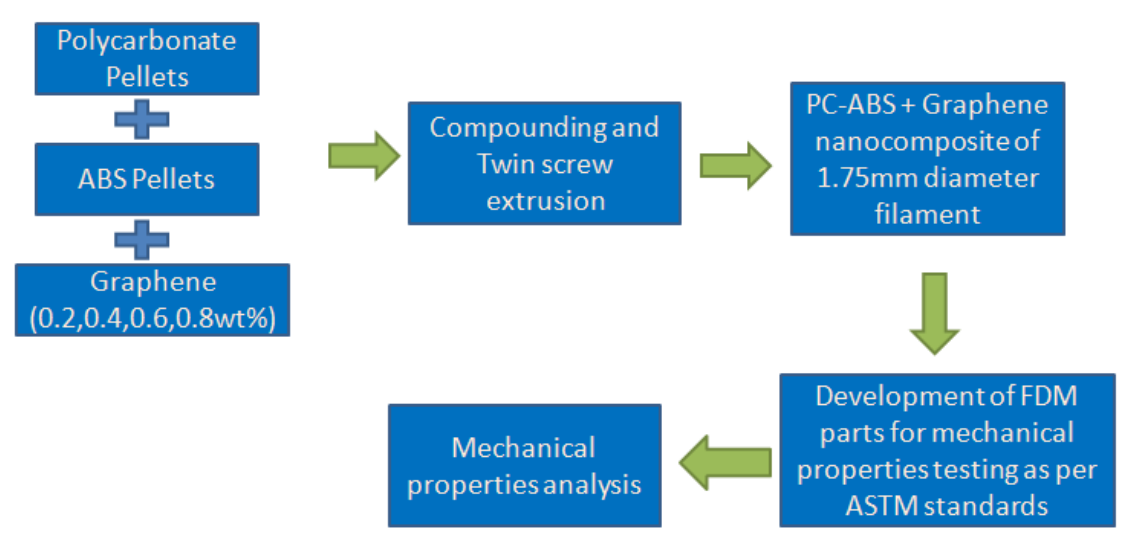
Figure 1. Flowchart of process flow.